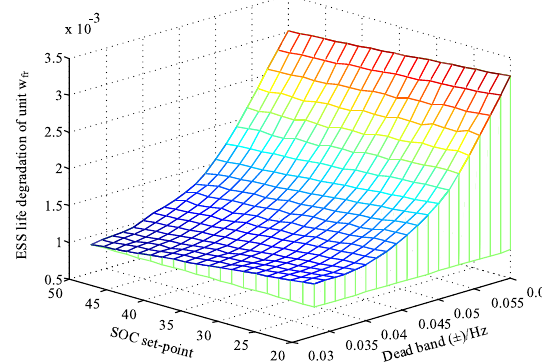
Fig. 9 The Li-ion ESS life degradation of unit frequency regulation power under different SOC set-points and different frequency regu- lation dead